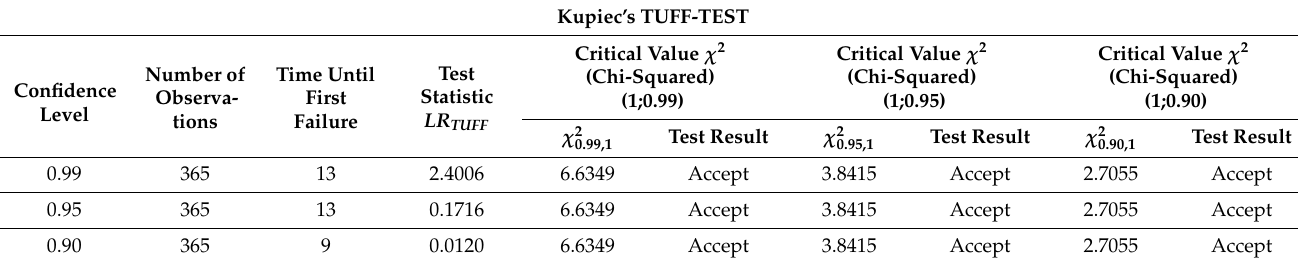
Table 11. Monte Carlo simulation VaR Kupiec’s